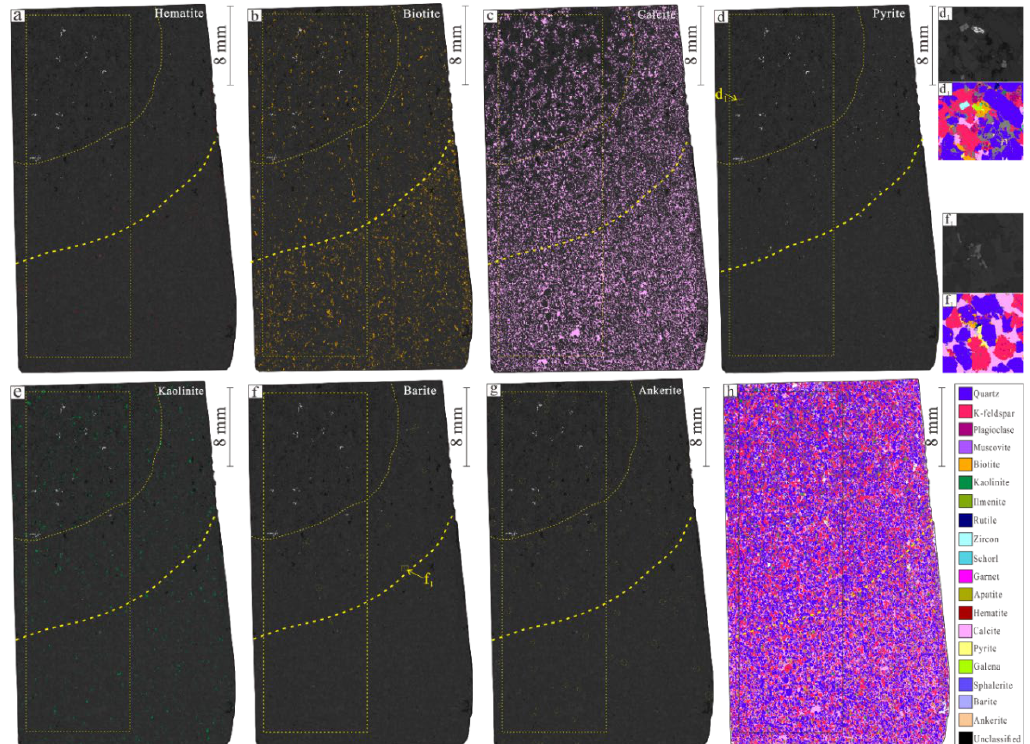
Figure 7. The mineral identification and mapping of red and bleached sandstone at the same sedimentary layer from the fifth member of the Lower Cretaceous Kezilesu Group used by TIMA. The distributions of hematite ( a ), biotite ( b ), calcite ( c ), pyrite ( d ), kaolinite ( e ), barite ( f ), ankerite ( g ) and whole phases ( h ) are shown in the red, bleached, and mineralized zones. Barite locally replaced by pyrite in the bleached front zone was shown in Figure ( f1 ), and fine-grained pyrite locally replaced by coarse-grained galena in the leached, slightly mineralized zone was shown in Figure ( d1 ).